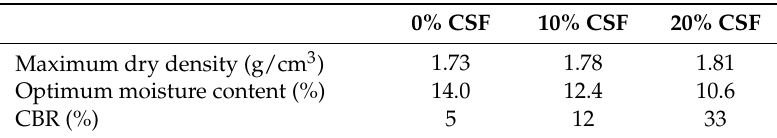
Table 7. Soil stabilization test